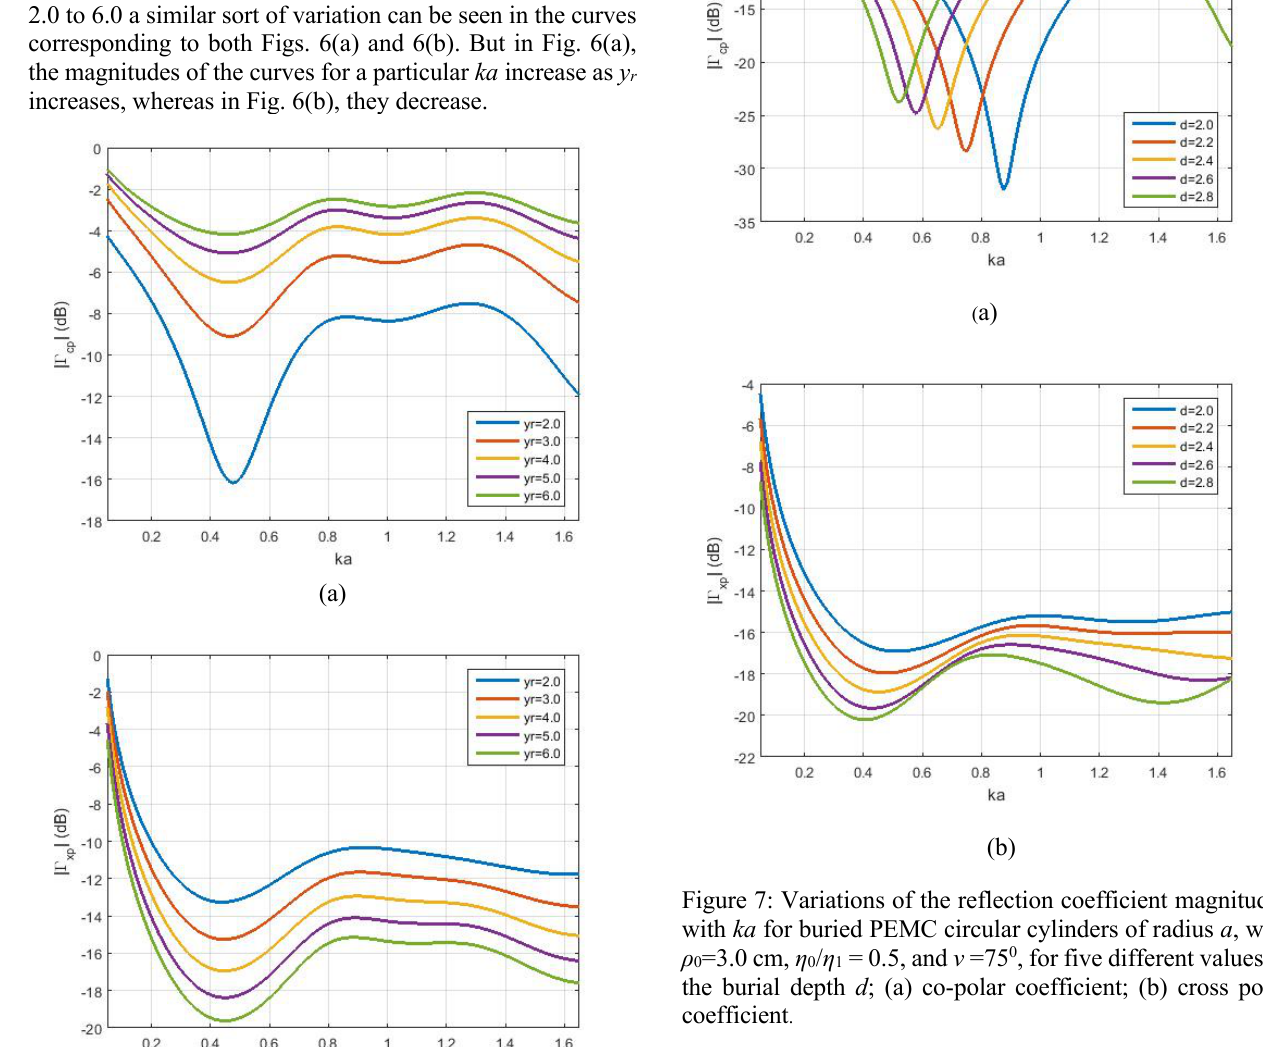
Figure 7: Variations of the reflection coefficient magnitudes with ka for buried PEMC circular cylinders of radius a , with ρ 0 =3.0 cm, η 0 / η 1 = 0.5, and ν =75 0 , for five different values of the burial depth d ; (a) co-polar coefficient; (b) cross polar coefficient